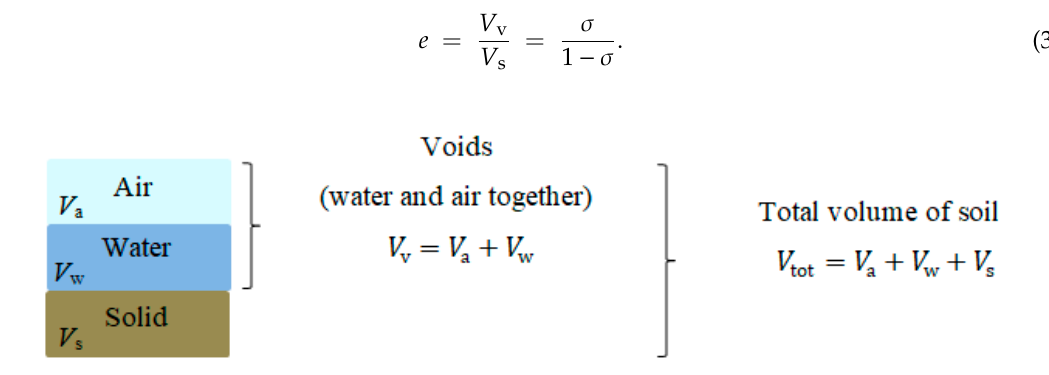
Figure 4. Sketch of the volumetric ratios of soils.